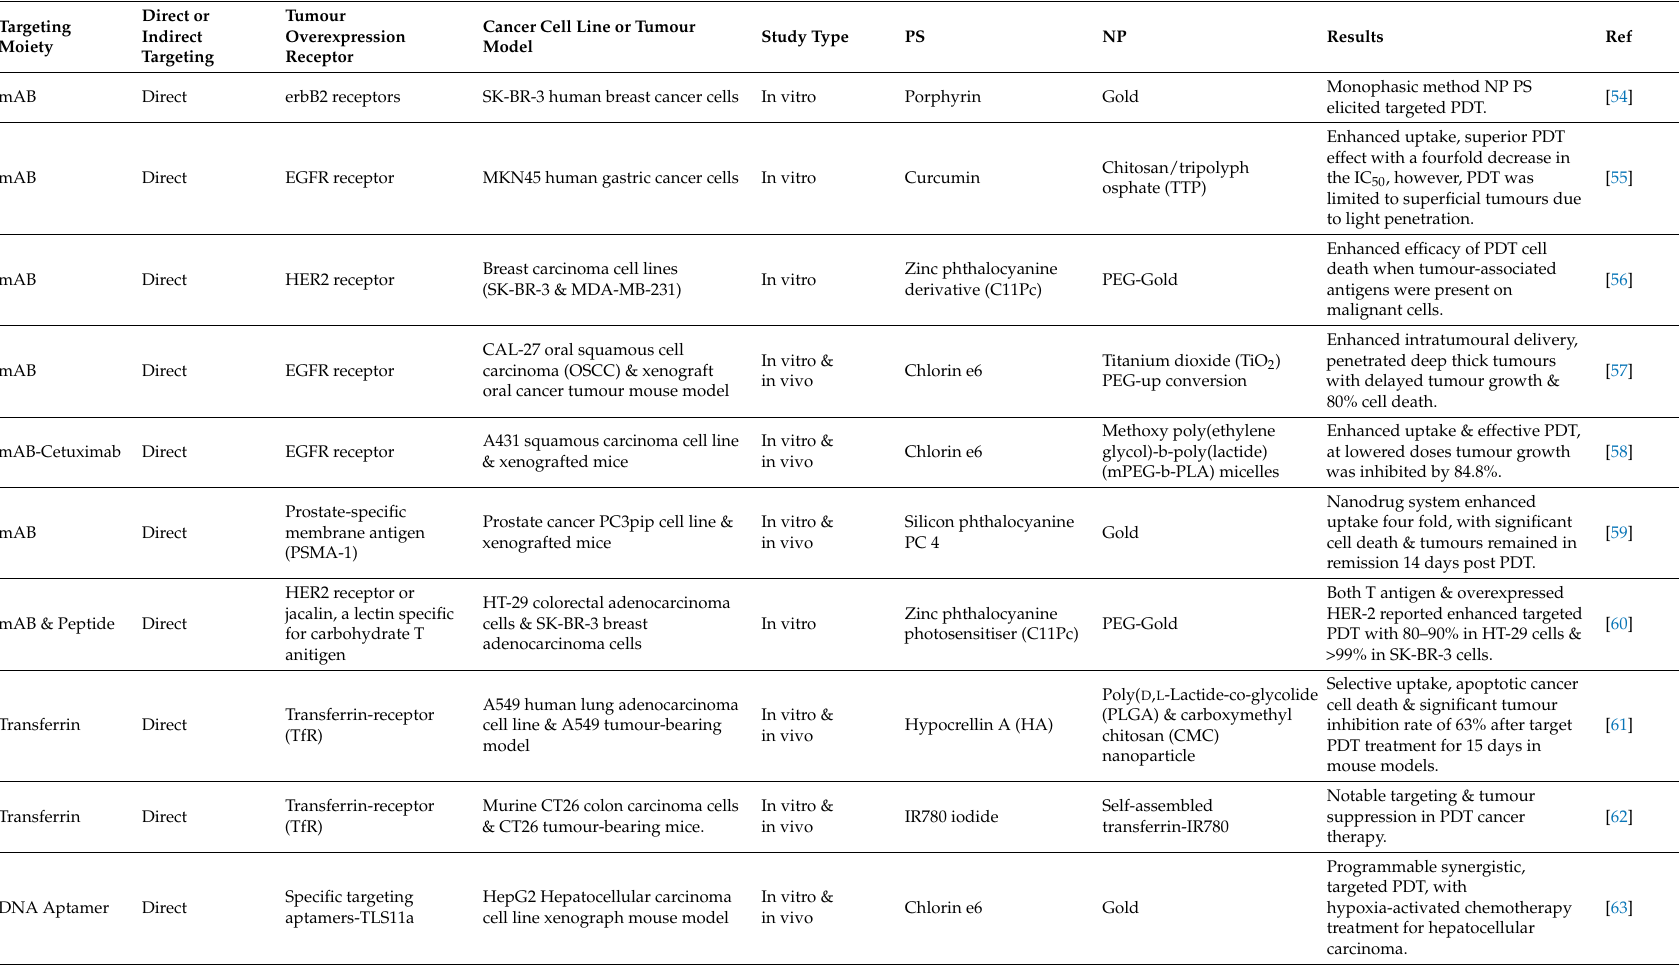
Table 2. Targeting moiety approaches used to enhance NP PSs active drug delivery systems in